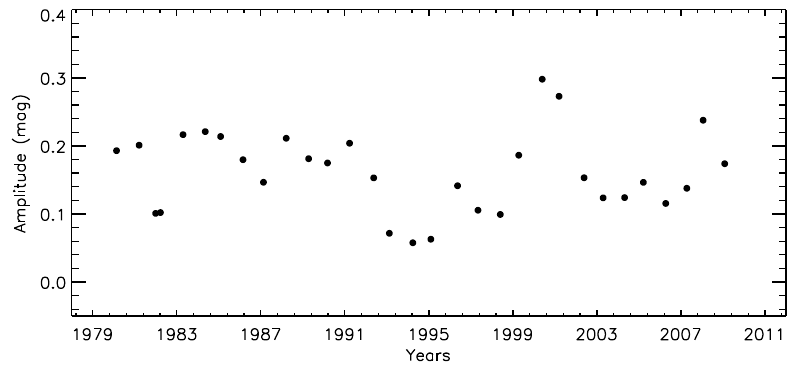
Fig. 6. Changes in the photometric amplitude values with